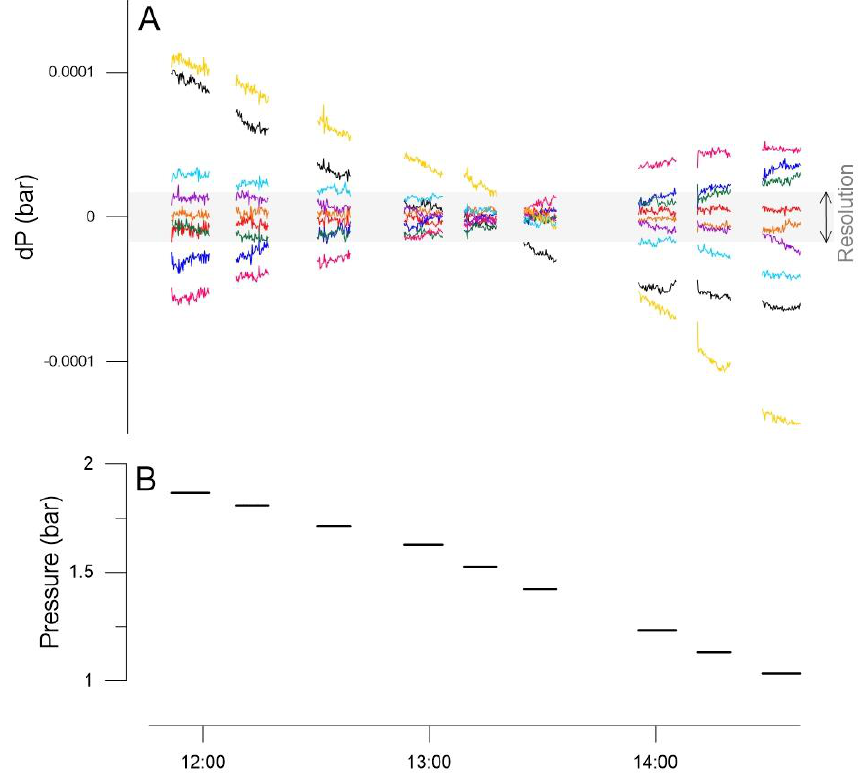
Figure A3. Sensitivity of pressure differences to pressure variations: ( A ) pressure difference; ( B ) pressure measurement.